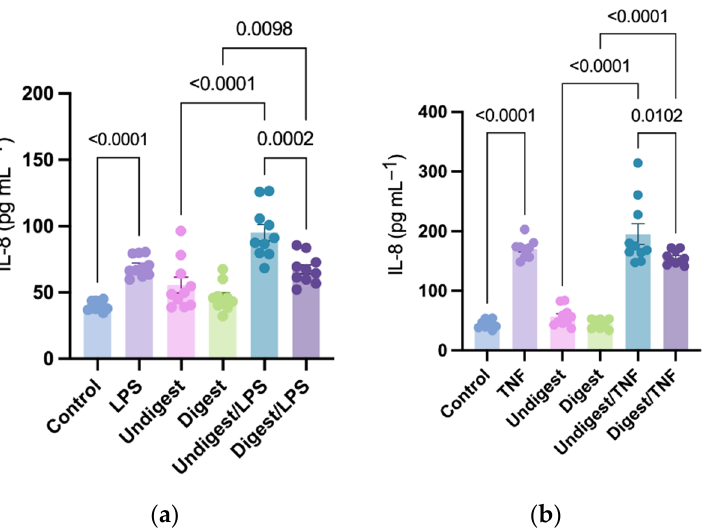
Figure 1. Production of interleukin-8 in human intestinal epithelial (Caco2BBe) cells in response to lipopolysaccharides ( a ) and tumor necrosis factor ( b ) stimulation after pretreatment with digested and undigested colostrum. Data represented are mean ± standard error (SEM) from nine to ten human colostrum samples (outliers removed). Data were analyzed through one-way analysis of variance (ANOVA) followed by Tukey’s multiple comparisons. IL-8 = interleukin-8; LPS = lipopolysaccharides; TNF = tumor necrosis factor.